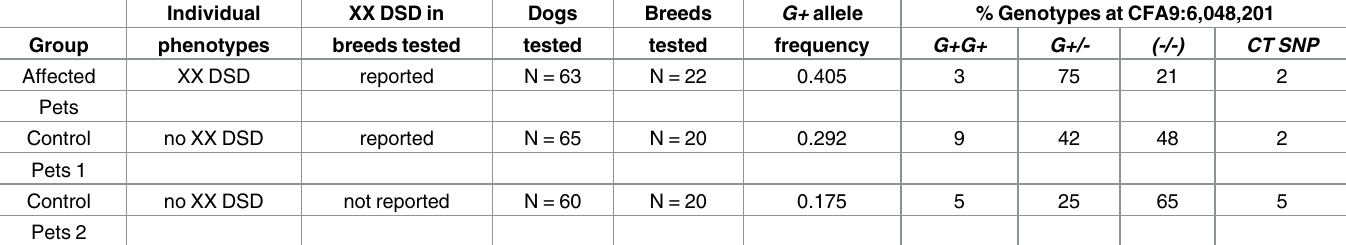
Table 2. Purebred pet dog groups genotyped with the custom array of selected WGS variants to identify those that are common to affected dogs of severalbreeds. Individual